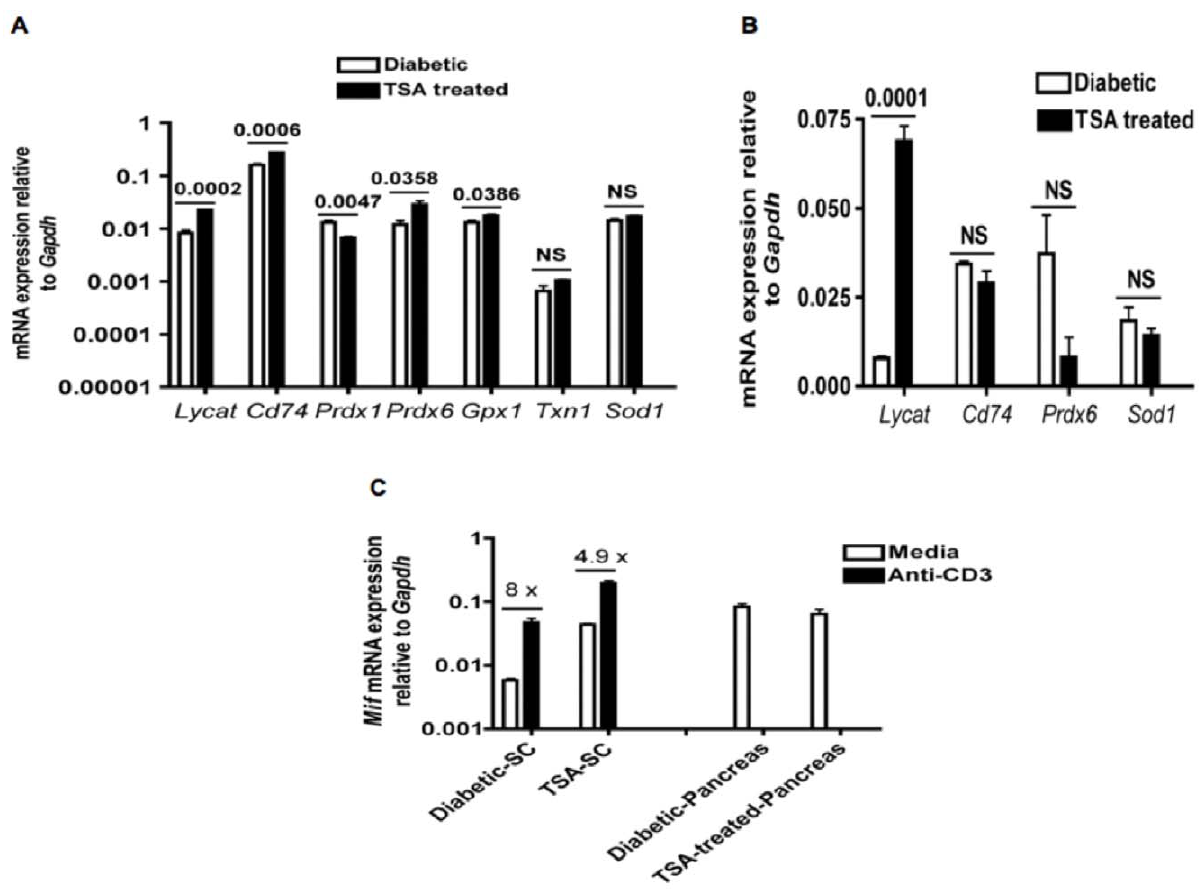
Figure 6. Modulation of genes implicated in various cellular functions by TSA treatment. ( A ) Total RNA was derived from splenocytes of diabetic and cured mice as indicated in Figure 4 & 5, and used for analyzing the expression of anti-oxidant genes and additional genes by qRT-PCR. ( B ) Total RNA derived from pancreata was probed similarly for the expression of indicated genes. ( C ) Splenic T lymphocytes from diabetic and cured mice were stimulated with immobilized anti-CD3, RNA extracted and analyzed for Mif expression. Steady state level expression of Mif was also analyzed in pancreata by qRT-PCR. Fold-increase in Mif gene expression is indicated. Each data point represents mean + / 2 SD of triplicate determinations. P values are given. NS indicates not significant. SC,